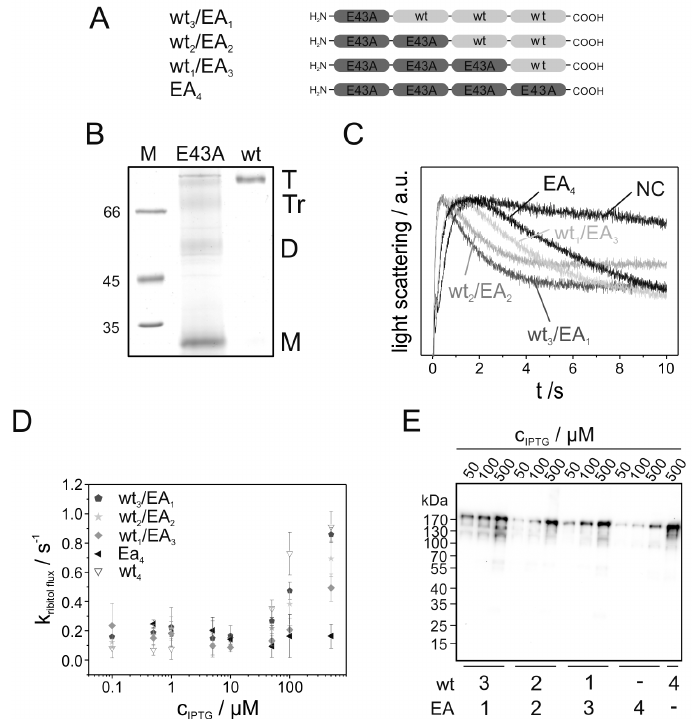
Figure 3. Activity of genetically fused GlpF heterotetramers. ( A ) Schematic representation of the fused GlpF oligomers. The light gray and dark gray boxes represent WT and E43A ‐ mutated GlpF, respectively. ( B ) SDS ‐ PAGE gel showing detergent ‐ solubilized and purified GlpF WT as well as the oligomerization ‐ impaired GlpF E43A. Purification and SDS ‐ PAGE analysis were performed as described in [30]. A 10% SDS gel was used and no additional SDS has been added to the sample buffer. The GlpF tetramer (T) shows a band at ~100 kDa whereas the band of the monomeric GlpF (M) is visible at ~30 kDa. Additionally, bands representing a GlpF dimer (D) and trimer (Tr) are visible for the mutant. ( C ) Typical light ‐ scattering curves of the fused GlpF tetramers WT 3 /EA 1 (dark gray), WT 2 /EA 2 (light gray), WT 3 /EA 1 (middle gray) and EA 4 (black) after induction of protein expression with 500 μ M IPTG. GlpF ‐ free control cells (NC) (gray) were transformed with the plasmid pMalp2 and treated exactly as GlpF ‐ expressing cells. The light ‐ scattering curves are the average of five measurements. ( D ) The rate constants of ribitol conductance facilitated by the GlpF tetramers WT 3 /EA 1 ( ), WT 2 /EA 2 ( ), WT 1 /EA 3 ( ) and EA 4 ( ◀ ) were determined by approximation of the light ‐ scattering curves using a single exponential decay function ( n = 3 ± SD). For comparison, the rate constants of the ribitol flux facilitated by the fused tetramer WT 4 ( ) are also depicted. ( E ) Western blot analysis, determining the expression level of the various fused GlpF tetramers. For the Western blot analysis, an antibody recognizing the GlpF C ‐ terminus was used.